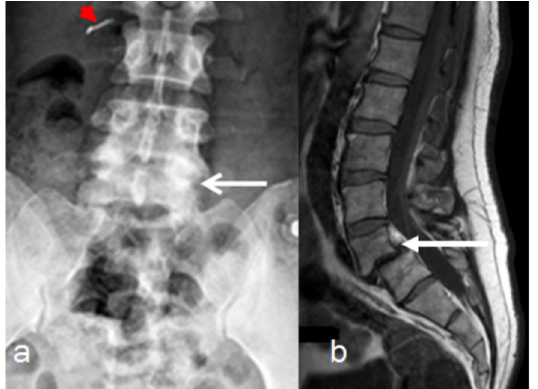
Figure 2. ( a , b ). Imaging of the parents, AP radiograph of the lumbar vertebrae of the 32-years-old- mother showed osteoarthritis of the facet joints of L5 (arrow) associated with diminution of the heights of L4/5. Note the increased level of calcification that signifies facet arthritis. Surprisingly, incidental diagnosis of early ossification of the abdominal aorta-red arrow head ( a ). Sagittal spine MRI of the 38-year-old father showed dysplastic spondylolisthesis of L4/5 (arrow) that might leads to spinal stenosis ( b ). Table 1. Phenotype/genotype of the family with spondylo-meg-epiphyseal-dysplasia.